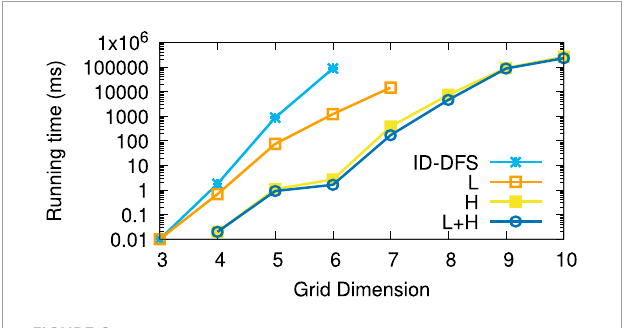
FIGURE 6 Average running times (in ms) for the type (a) (coast-like) grids.